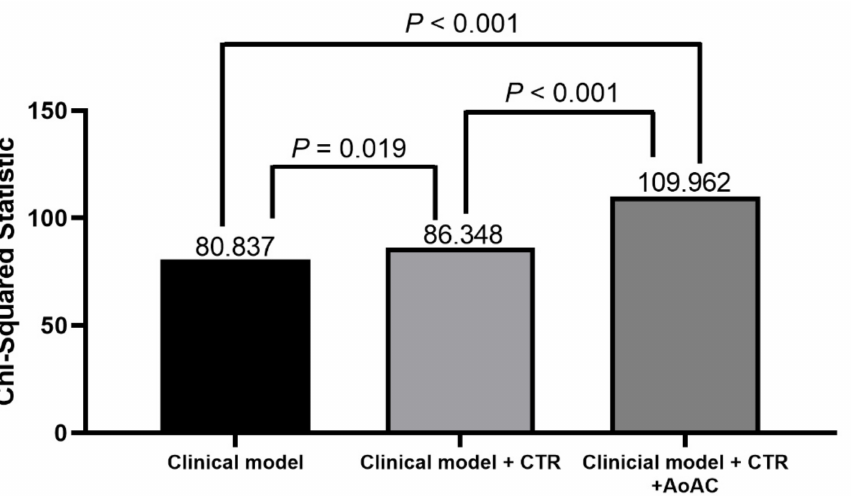
Figure 3. The assessment of predictive model of overall mortality. The clinical model included age, sex, smoking history, diabetes, coronary artery disease, cerebrovascular disease, fasting glucose